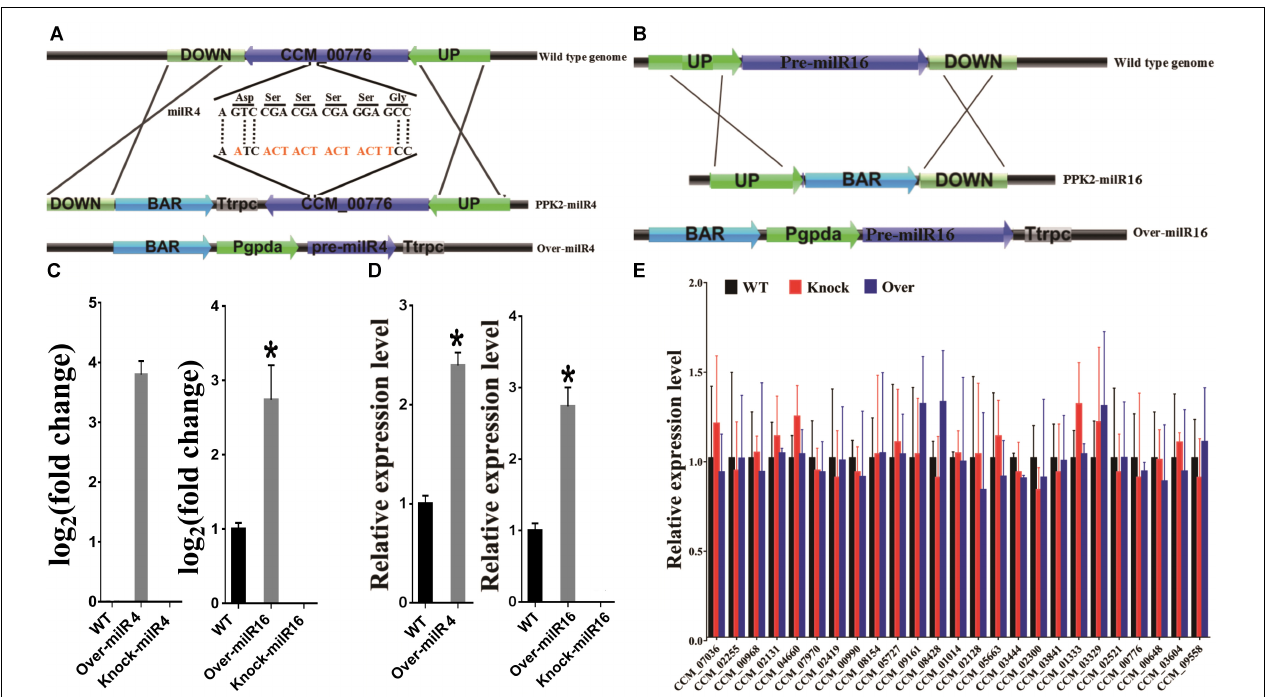
FIGURE 3 | Construction of milR4 or milR16 disruption and over-expression mutants. (A) Schematic representation of the plasmids that were used for disruption and over-expression of the milR4. milR4 location sequences of (5 (cid:48) -A GTC CGA CGA CGA GGA GCC-3 (cid:48) ) were changed to (5 (cid:48) -A ATC ACT ACT ACT ACT TCC-3 (cid:48) ) based on the degeneracy of codons. (B) Schematic representation of the plasmids that were used for disruption and over-expression of the milR16. (C) Real-time PCR analysis of milR4 and milR16 expression from mycelium wild type strain and different mutants. Mixed conidia of PM53-1 ( MAT1-1 ) and PM53-2 ( MAT1-2 ) at ratios of 1:1 was inoculated onto PDA plates and incubated at 23 ◦ C under a 12 h:12 h light/dark cycle for 14 days for RNA extraction. (D) Real-time PCR analysis of milR4 and milR16 expression from fruiting bodies (52 days) of wild type strain and different mutants. N, no fruiting body formation for the detection. (E) Analysis of the relative expression levels of milR4 and milR16 predictive miRNA target genes in wild type strain and different mutants. Data are expressed as means ± SE of values from six independent experiments. The asterisk “ ∗ ” represents a significant difference level of P < 0.05.